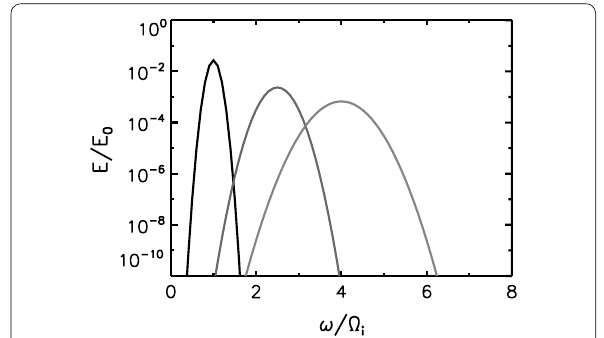
Fig. 2 Slices of the energy spectrum in Fig. 1 at wavenumbers of k s V A /� i = 0.2 ( left curve ), k s V A /� i = 0.5 ( middle curve ), and k s V A /� i = 0.8 ( right curve )